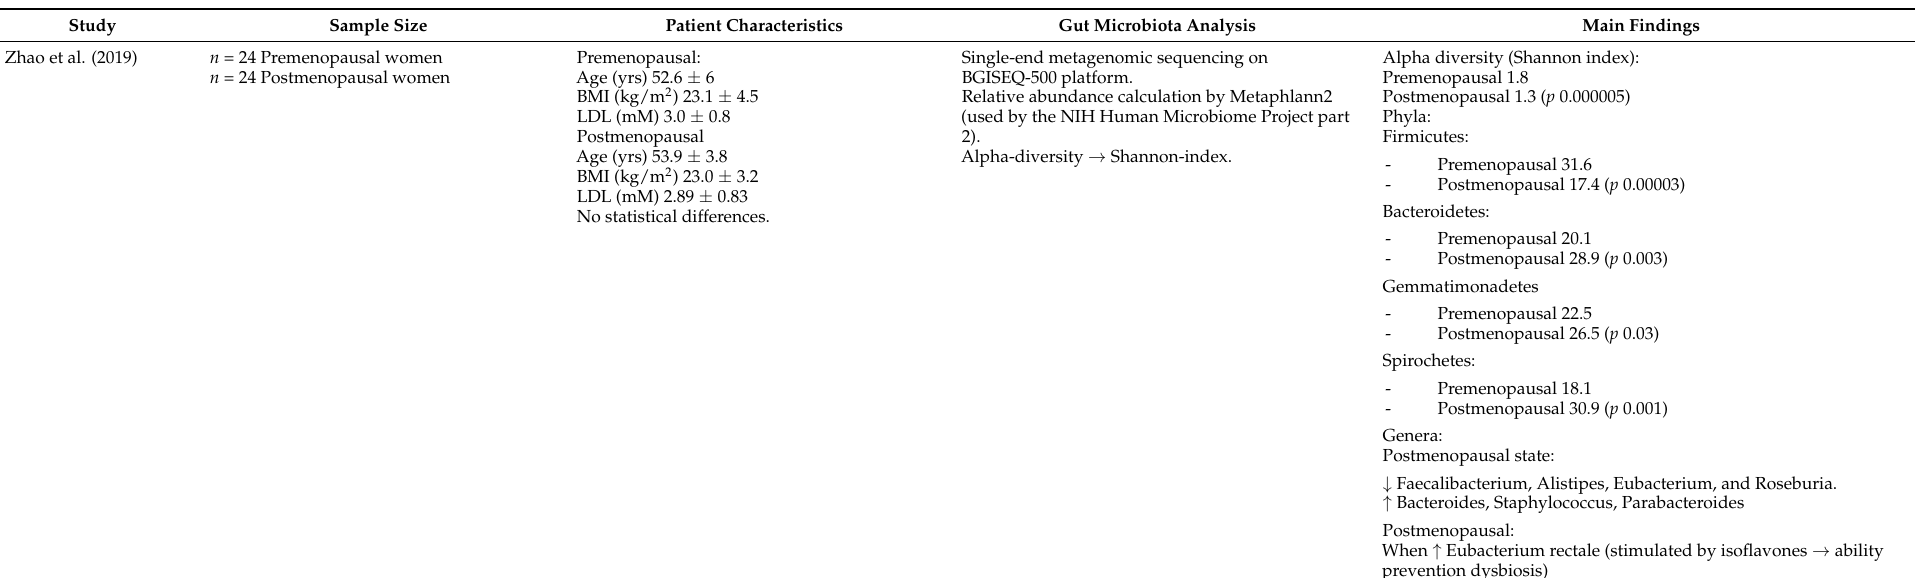
Table 1. Characteristics and summary, of studies included for research questions 1–2 (estrogen/menopause and gut microbiome).